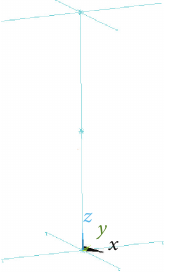
Figure 4: FEM model of free standing fuel rack.